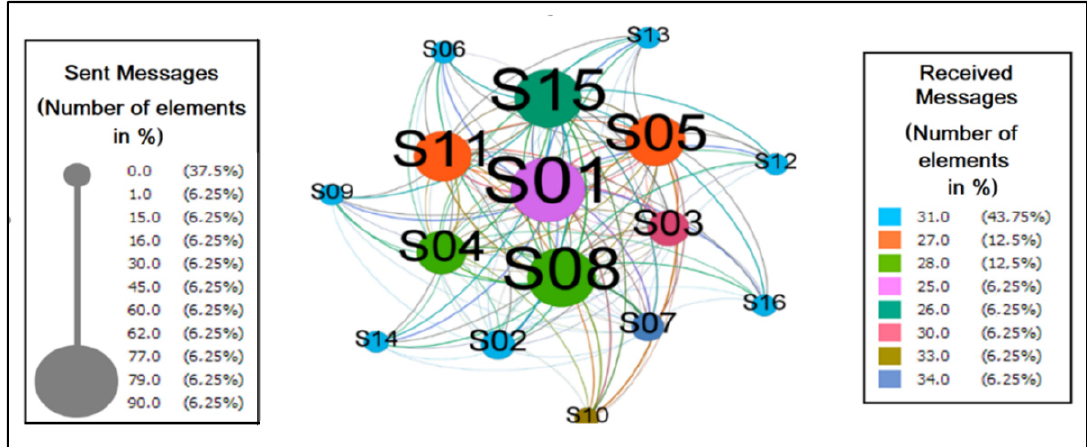
Figure 8. Messages between peers by weighted input and output grades.